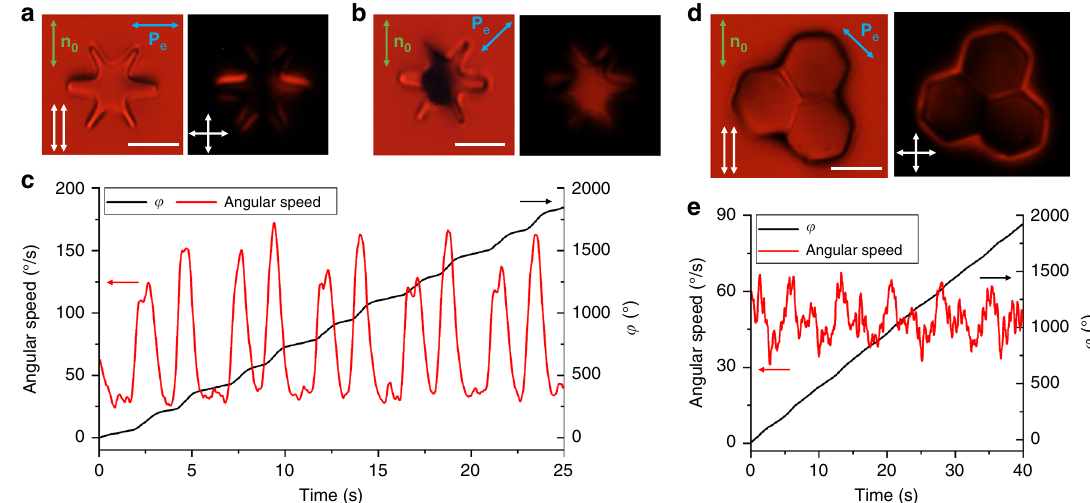
Fig. 8 Spinning of a cogwheel-like particle and self-assembled hexagonal platelets. a , b Polarizing optical micrographs obtained with red imaging light and under linearly polarized blue light illumination P e perpendicular to n 0 a , and at 45 to n 0 b , when platelet rotates. c Corresponding angular speed versus time for P e at 45° to n 0 . d Polarizing optical micrograph obtained with red imaging light and under linearly polarized blue light with P e at − 45° to n 0 . e Corresponding angular speed and azimuthal orientation angle φ versus time. Scale bars are 5 µ